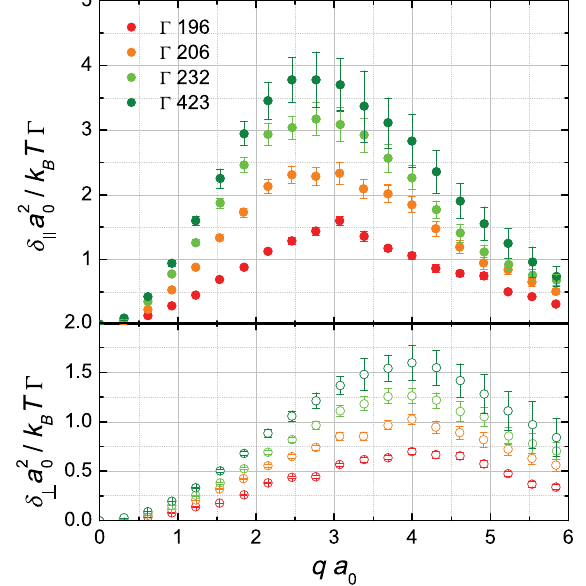
FIG. 2. Dispersion relations of longitudinal and transverse excitations rescaled with the linear dependence on Γ expected in harmonic systems (filled and empty symbols in the top and bottom plots, respectively). The curves for different temperatures do not collapse, which can only be explained if structural rearrangement occurs. Because of the better optical resolution, only trajectories of big particles are analyzed here and in the following plots.